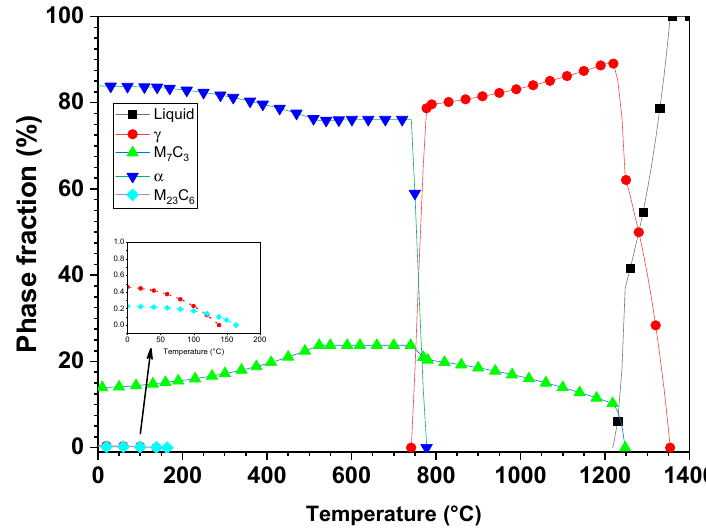
Figure 2. JMatPro simulation of volume fraction phases vs temperature for the Fe-12Cr-2.08C alloy, in the case where the formation of the M 7 C 3 and M 23 C 6 carbides.